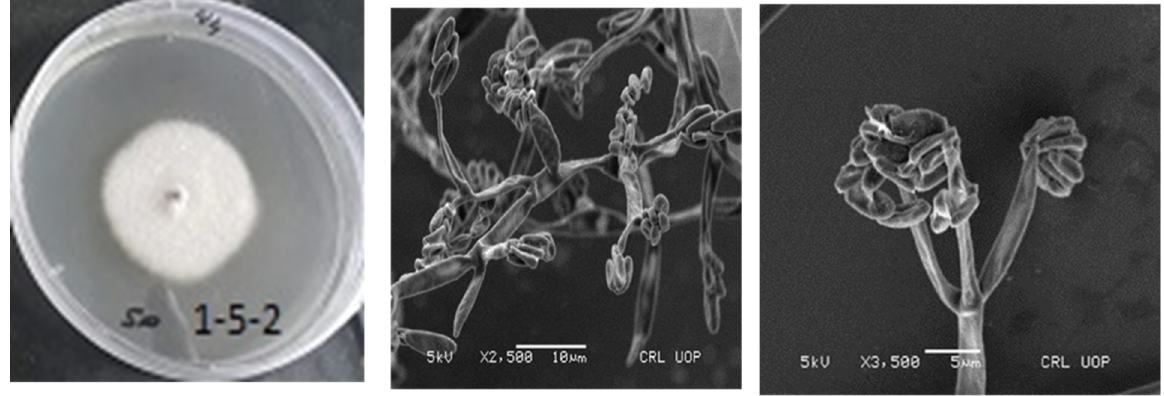
Figure 5. Selected fungal endophytes showing their mycelia, hyphae, conidiophore, and co ‐ nidia/spores .